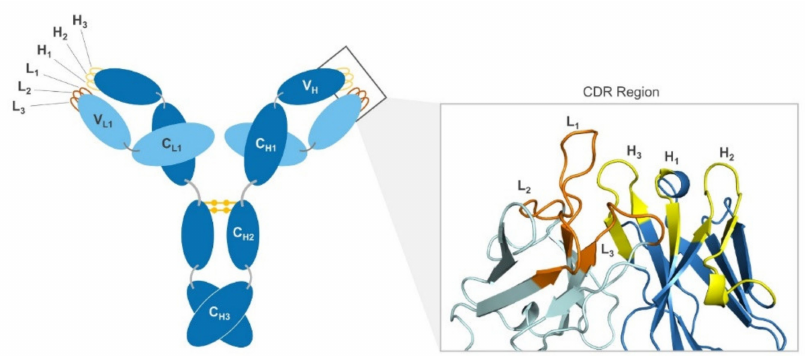
Figure 1. Schematic of antibody and ribbon diagram of variable region. The heavy chain (H) of the antibody is depicted in dark blue, while the light chain (L) is shown in light blue. Both chains show labels C for constant region and V for variable region. The complementarity-determining region (CDR) is shown as orange loops on the light chain and yellow loops on the heavy chain. On the right, a ribbon diagram of a CDR is shown with light and heavy chain CDR loops highlighted and labeled (PDB: